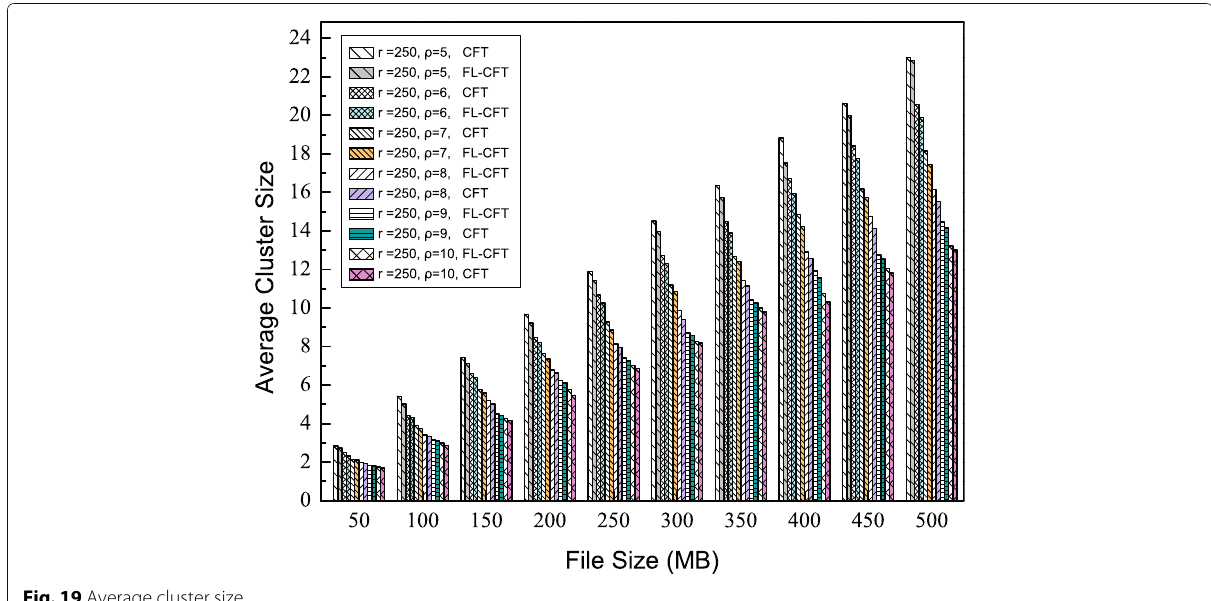
the maximum file transfer volume of FL-CFT varies from 307 to 425 MB. The reason why the maximum file trans- fer volume of CFT and FL-CFT is much greater is that a file can be transferred through multiple cluster